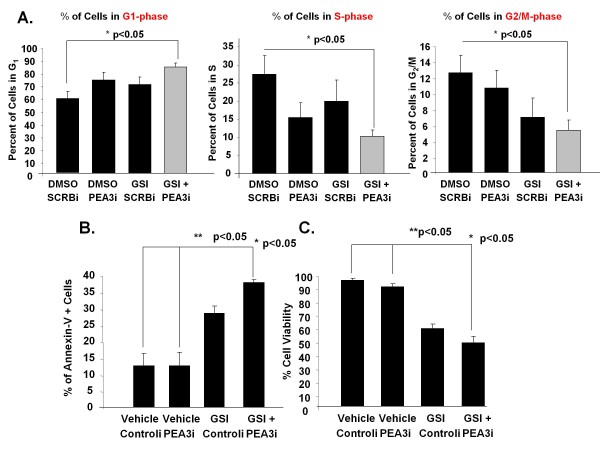
Dual inhibition of Notch and PEA3 inhibits cell proliferation and induces apoptosis. MDA-MB-231 cells were transfected with scrambled or PEA3 siRNA alone or were treated with vehicle (DMSO) or a γ-secretase inhibitor (MRK-003 GSI), or a combination thereof, for 48 hours. Cell cycle analysis (A) and annexin V staining (B) were performed by using flow cytometry. (C) Percentages of viable cells were measured by the trypan blue exclusion method using a standard light microscope (×10 original magnification). The mean percentage and standard deviation of cells in each experiment were plotted. Statistical significance was determined by performing analysis of variance for multiple comparisons. The error bars represent standard deviations of the mean for three independent experiments.